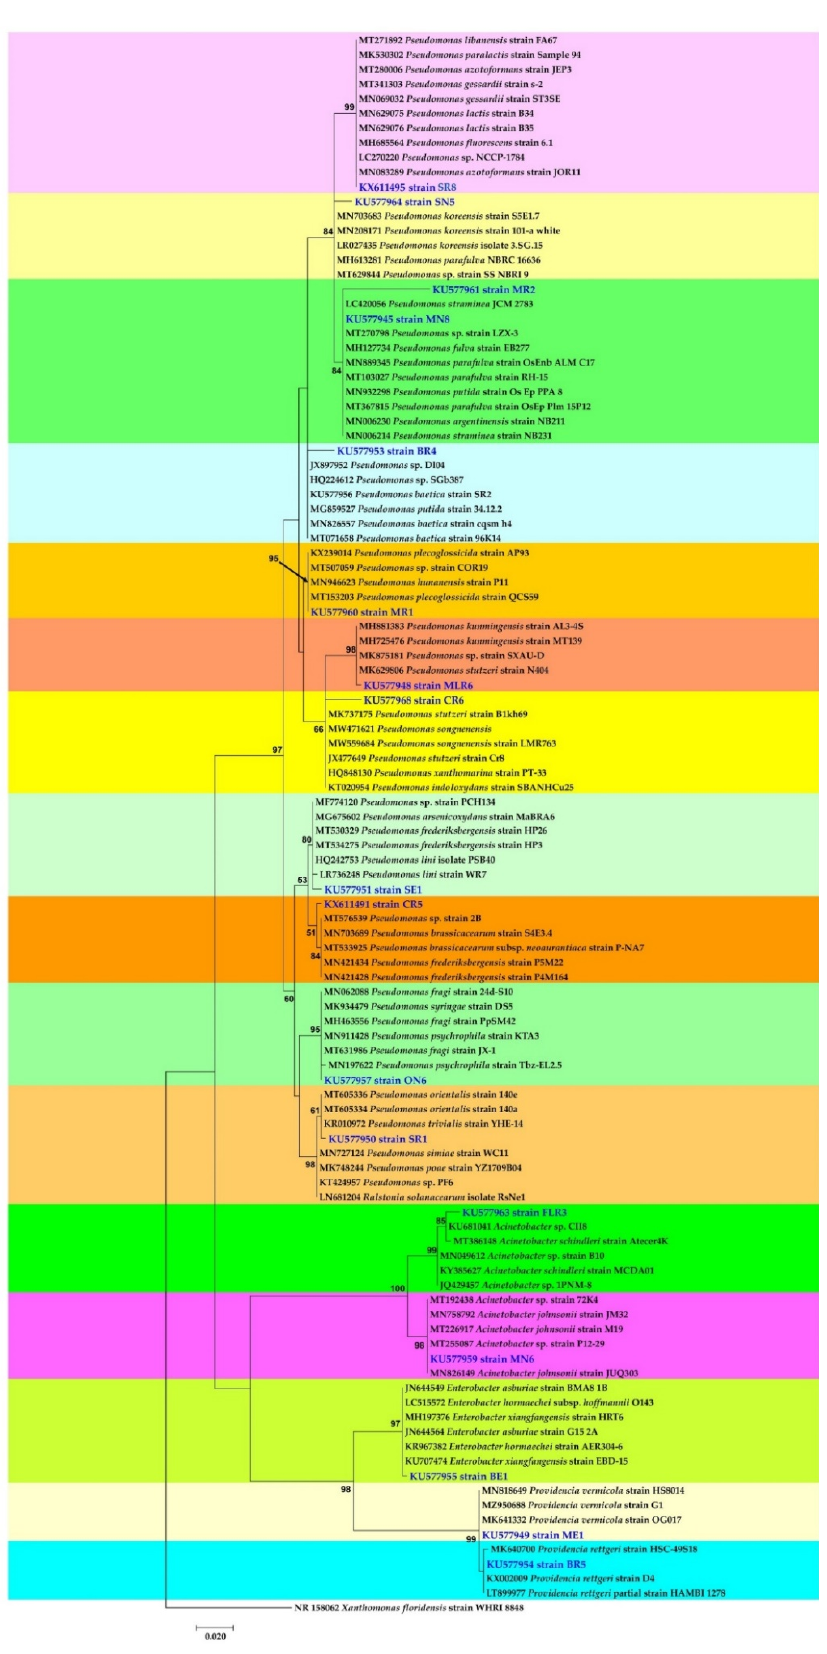
Figure 5. Maximum likelihood phylogenetic tree of seventeen Gram-negative bacteria. Xanthomonas floridensis WHRI 8848 was used as outgroup. Supports for branches were assessed by bootstrap resampling of the data set with 1000 replications.